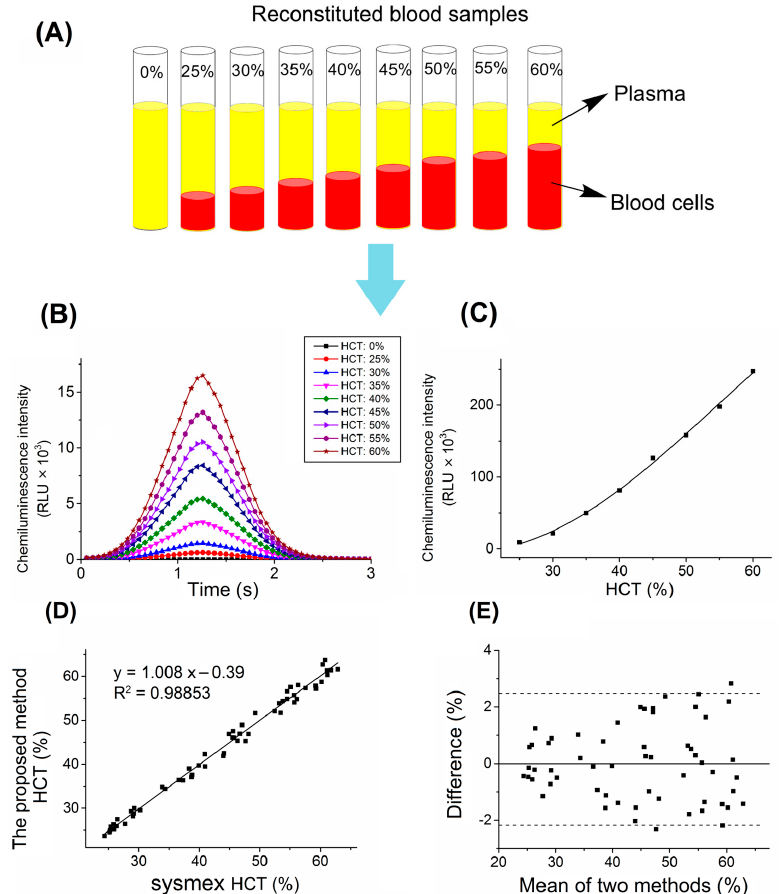
Figure 1. ( A ) Procedure to reconstitute whole blood to target HCT levels ranging from 0 to 60%. ( B ) Chemiluminescence curves of hemoglobin in the reconstituted blood samples at different HCT levels were generated by MAGICL 6000. ( C ) Standard curves were obtained by the chemiluminescence biosensor method for HCT measurement. Comparison study between the established method and the clinical method (Sysmex XE 5000) for HCT measurement. ( D ) Correlation analysis; ( E ) Bland-Altman analysis.